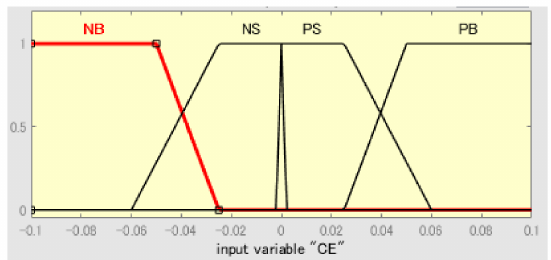
Figure 15. Wind turbine FLC membership for CE .